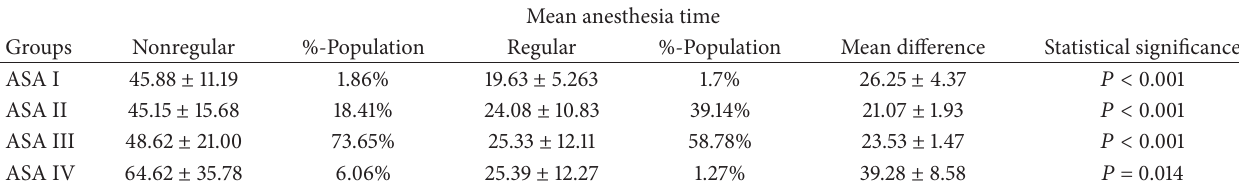
Table 1: Comparison of anesthesia times between various ASA classes in both groups.